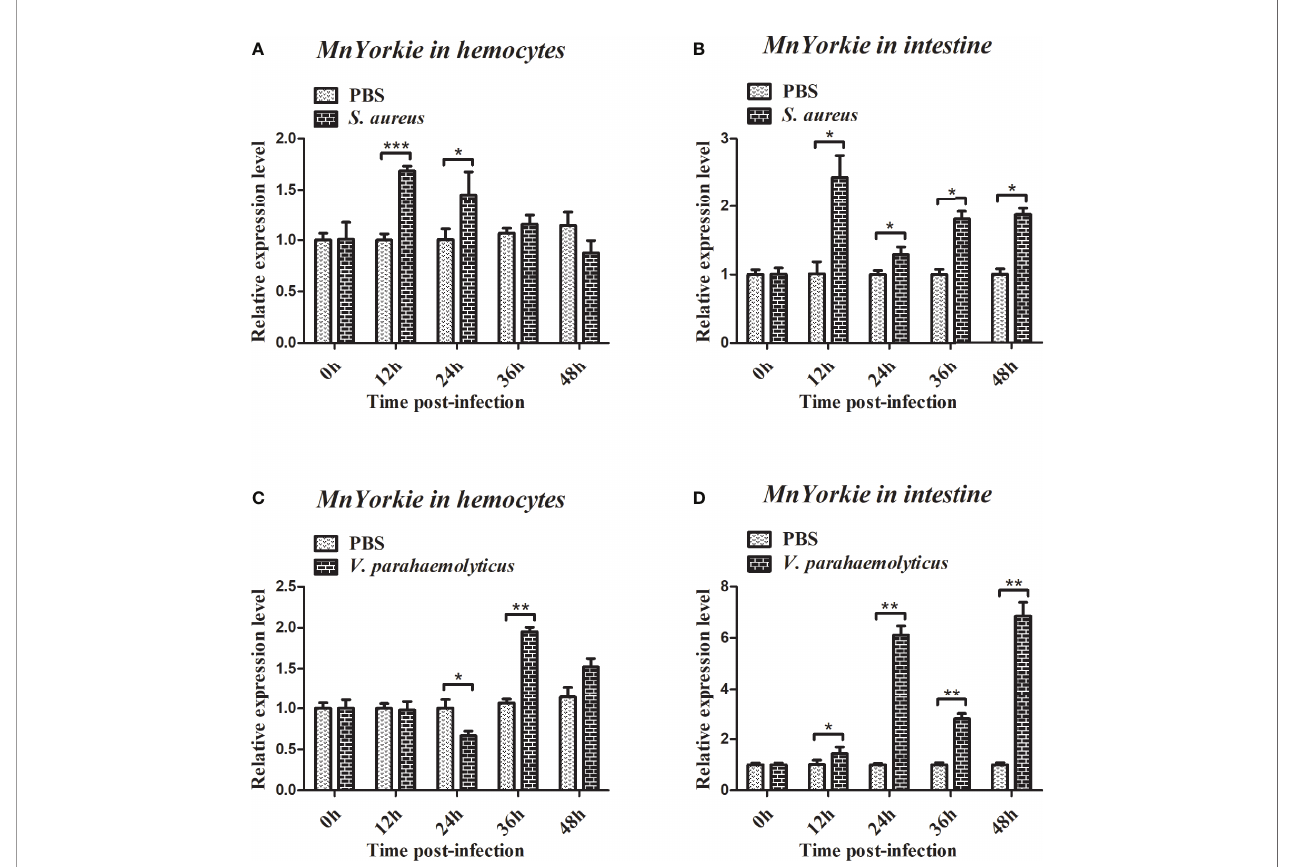
FIGURE 4 | Relative transcription levels of MnYorkie in the hemocytes and intestines of bacterial-infected prawns. At 0, 12, 24, 36, and 48 h after S. aureus (A, B) or V. parahaemolyticus (C, D) infection in prawns, hemocytes and intestines were collected and processed for the RT-qPCR analysis of MnYorkie expression. b -actin was used as an internal control. Data are presented as mean ± SD, N = 5. Signi fi cance was compared between the experimental group and the PBS-injected group at the same time point. Signi fi cant differences are indicated with an asterisk at P < 0.05, two asterisks at P < 0.01 or three asterisks at P <